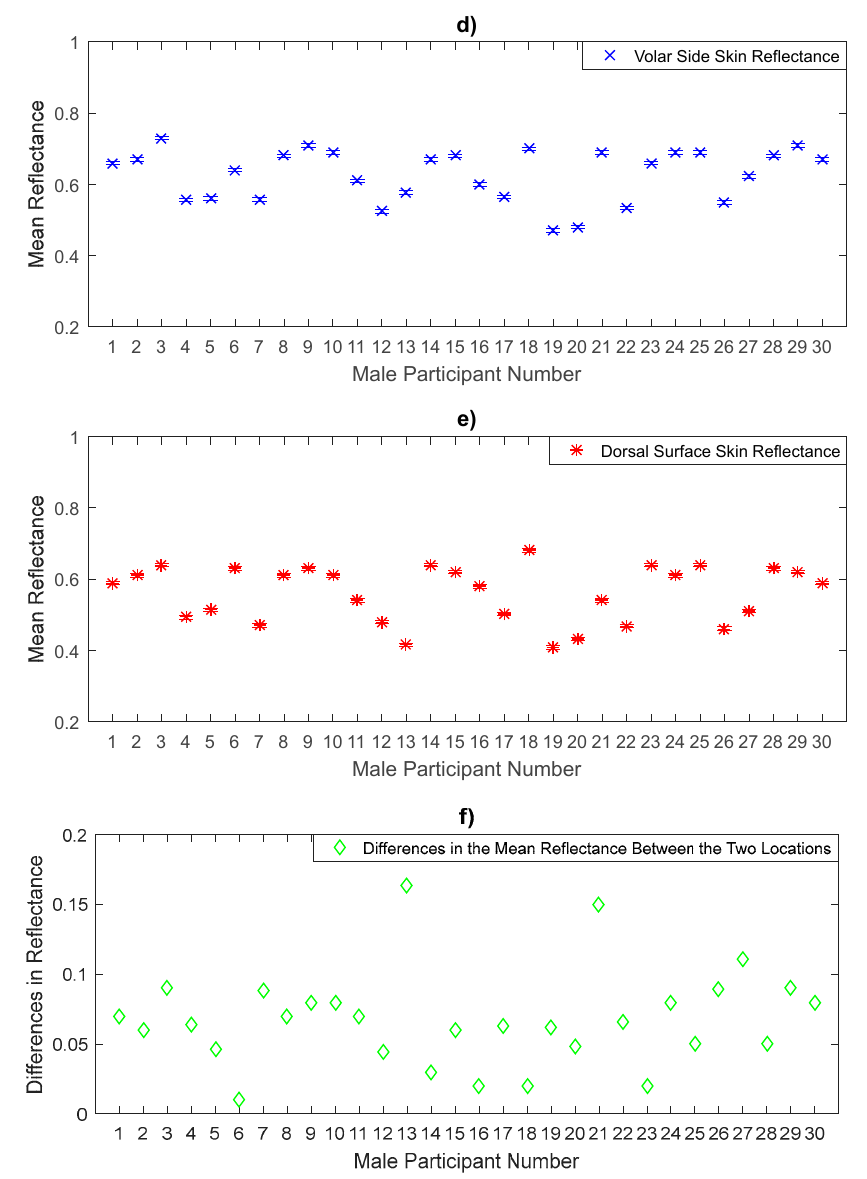
Figure 9. Measurements of human skin reflectance on the volar side ( d ) and the dorsal surface skin ( e ) for a sample of 30 male participants. The mean differences in reflectance values between the two locations ( f ) are in the range of 0.01 to 0.163.